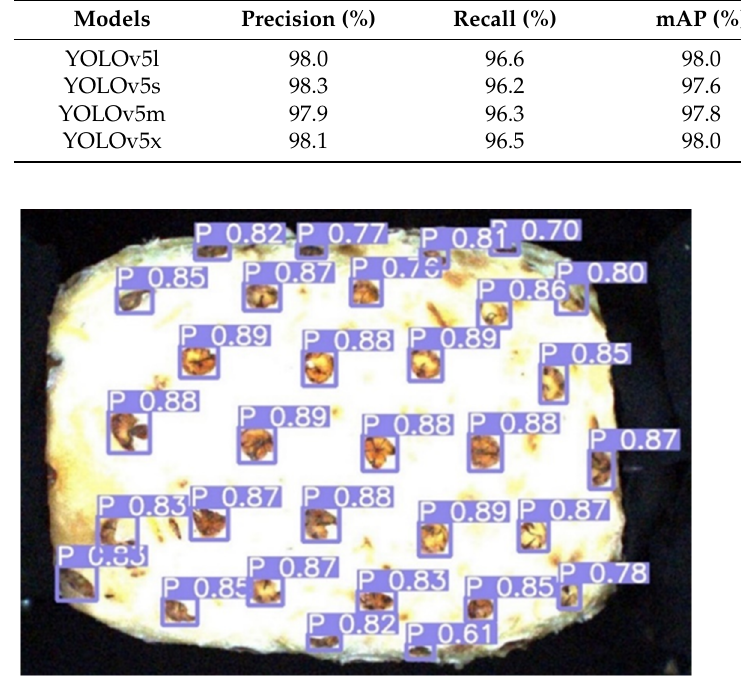
Figure 14. YOLOv5l detection effect diagram. Average time is the time to detect one pineapple eye image.